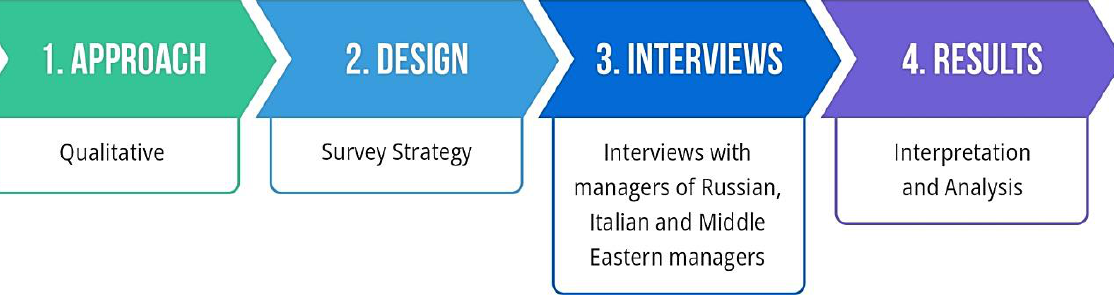
Figure 2. Qualitative analysis